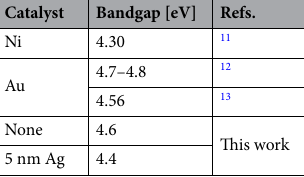
Table 1. Previously reported bandgaps of β-Ga 2 O 3 nanowires.